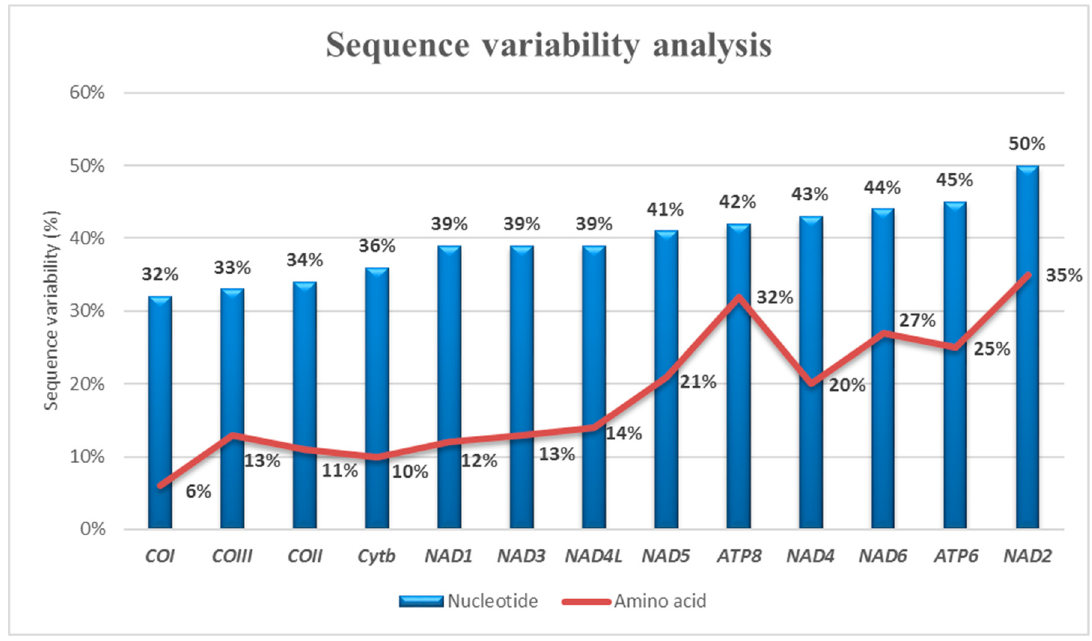
Figure 5. Gene ‐ by ‐ gene analysis of nucleotide and amino acid sequence interspecific variability. The genes were sorted by increasing variability values. The gene with the lowest value is COI , while the gene with the highest value is NAD2.